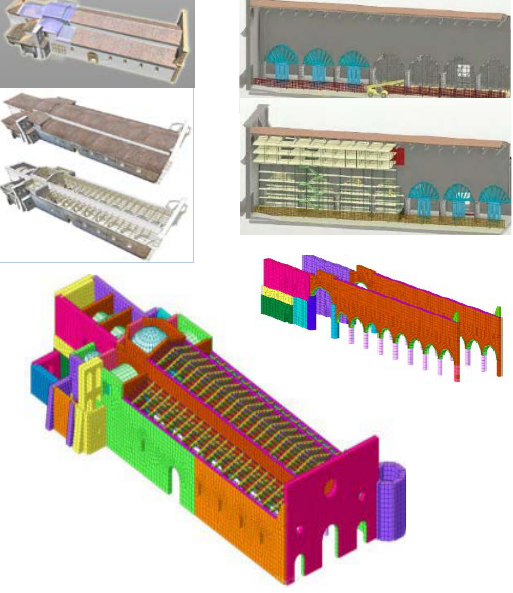
Figure 13. HBIM interoperability. The HBIM of the Basilica (BIM to FEA Revit © Midas